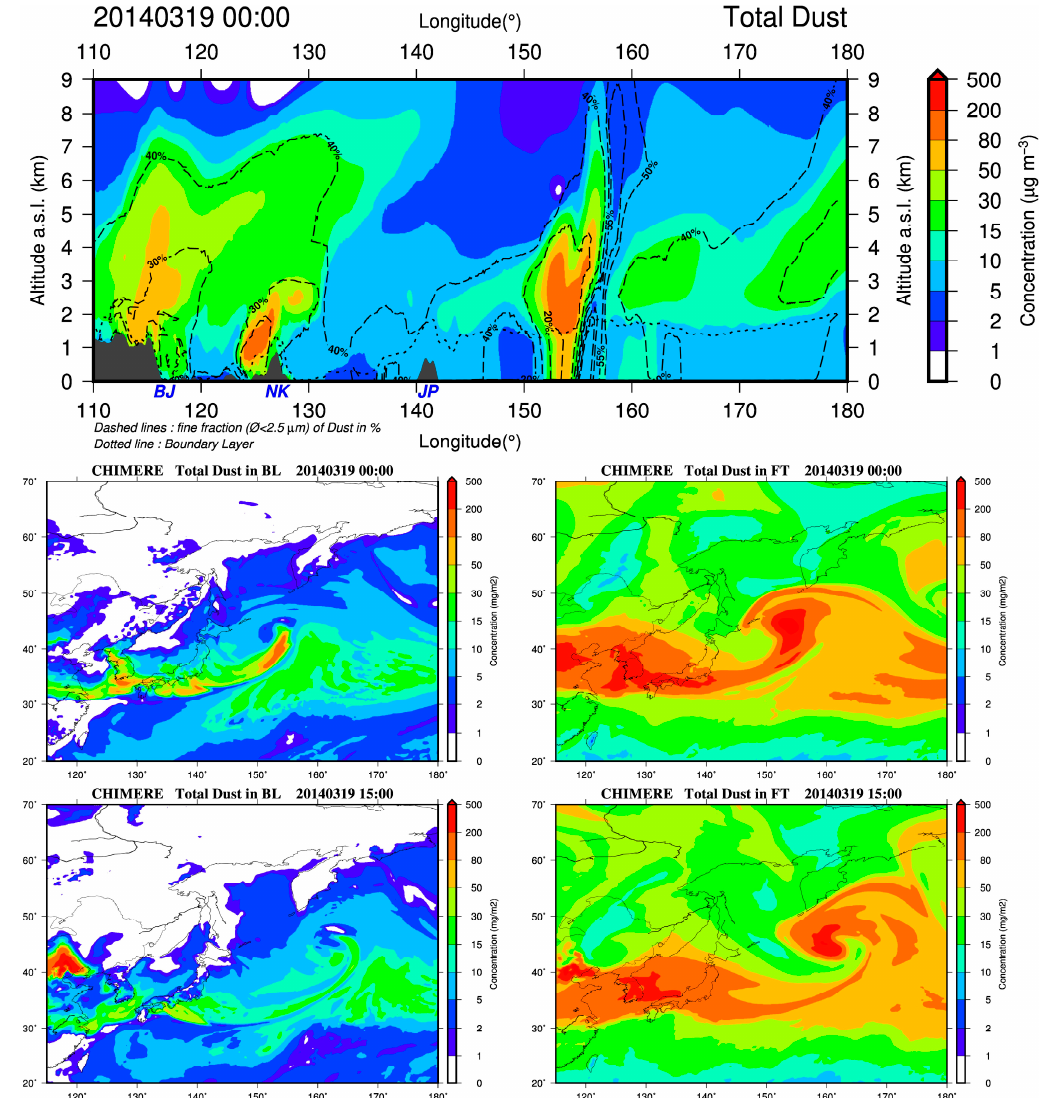
Figure 29. Evolution of the different dust plumes toward the Pacific Ocean simulated by CHIMERE for 19 March 2014 00:00 UTC. ( Top ) Longitudinal cross section of total dust concentrations fields (altitude versus longitude) at 39.9° N (Beijing latitude) from longitude 110° E to 179° E passing over Beijing (BJ), North Korea (NK) and Japan (JP) on 19 March 2014 00:00 UTC and travelling over the Pacific Ocean in a westerly flux. The dotted line represents the height of the boundary layer, the dashed lines represent the fraction of fine dust in percent. ( Middle, bottom ) Dust concentrations in the boundary layer (BL) and the free troposphere (FT) on 19 March 2014 00:00 and 15:00 UTC.